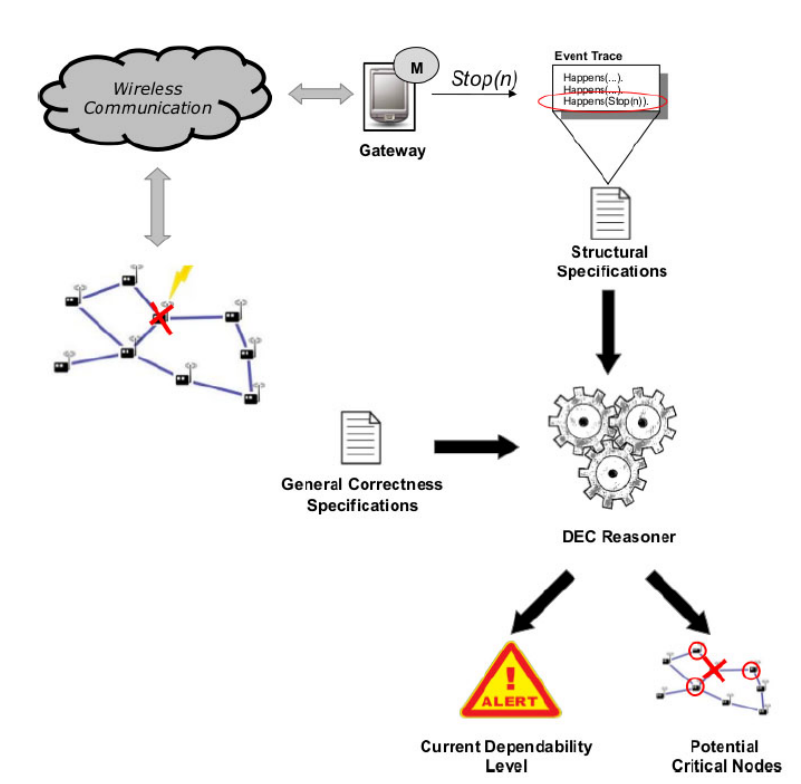
Figure 5. Application scenario in runtime